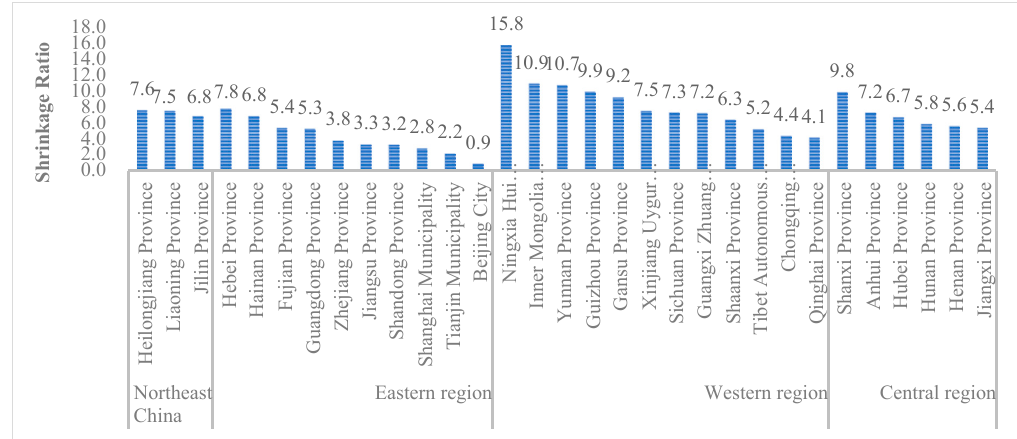
Figure 3. Spatial distribution of the degree of urban shrinkage.